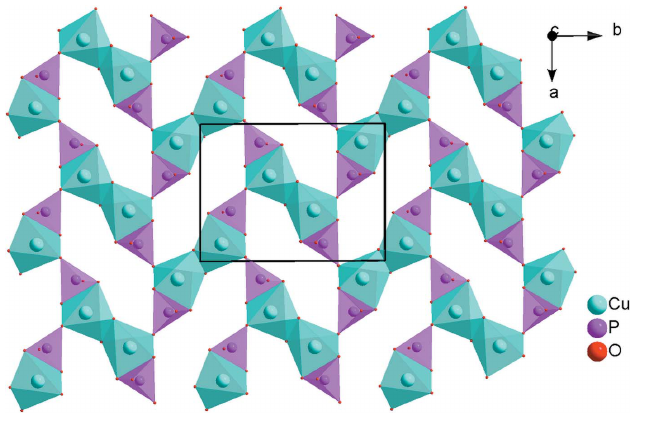
Figure 2 Projection along [001] of [Cu 2 P 2 O 12 ] copper phosphate sheets in the crystal structure of NaCuIn(PO 4 ) 2 .